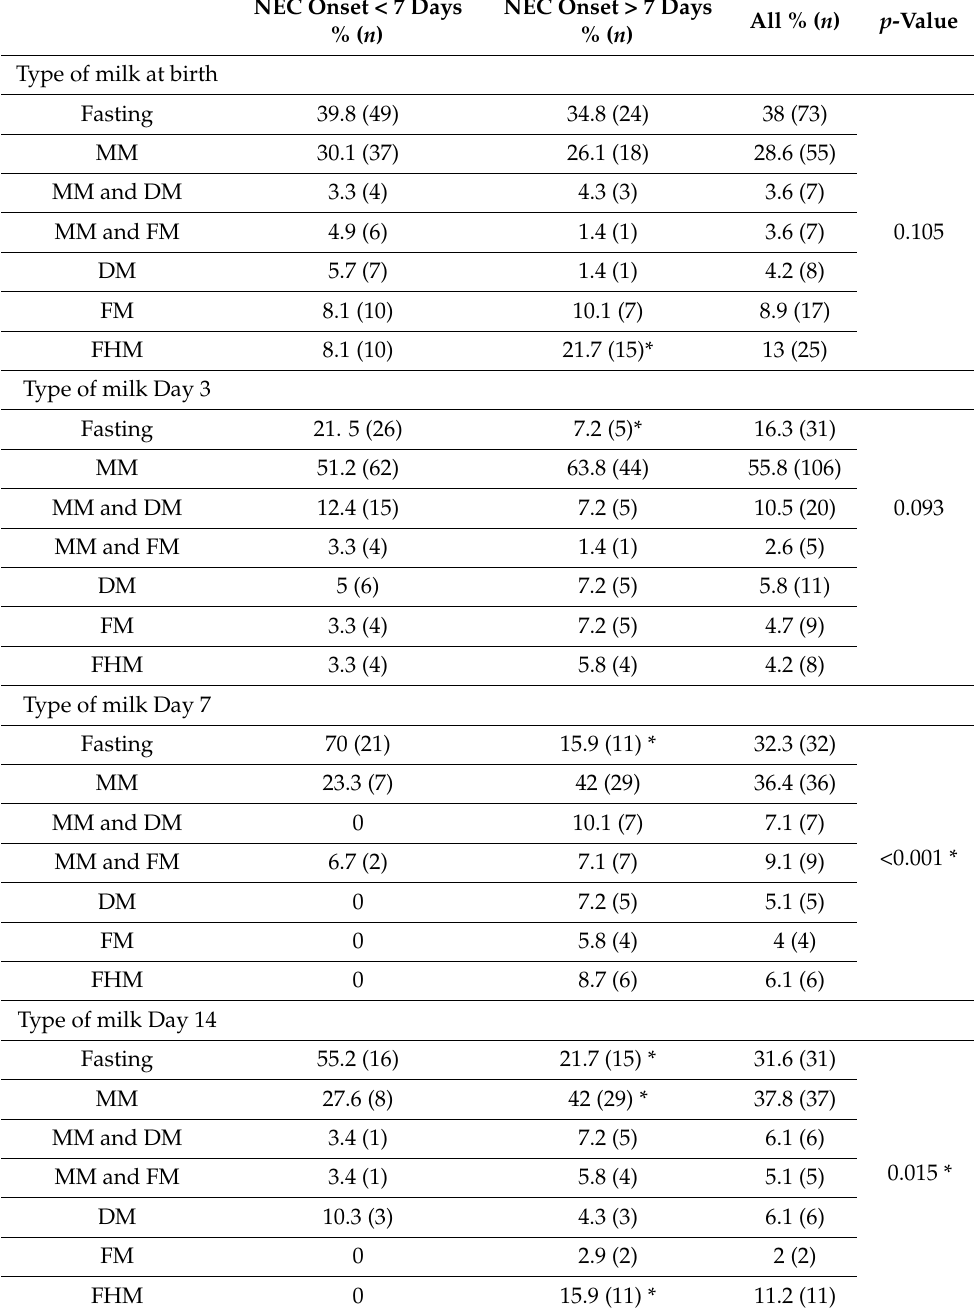
Table 8. The onset of NEC at different time points in relation to fasting and type of